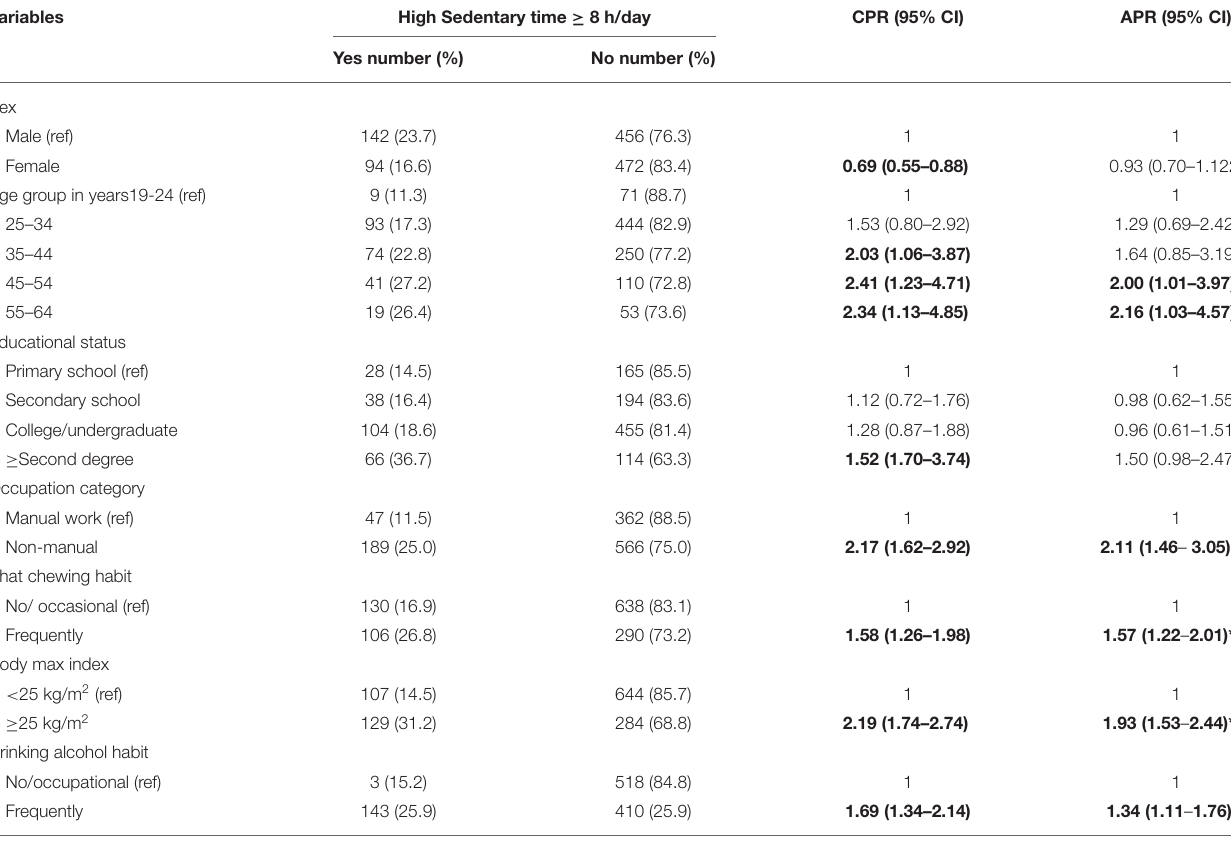
TABLE 7 | Factors associated with high sedentary behavior among study participants in Eastern Ethiopia, 2019.